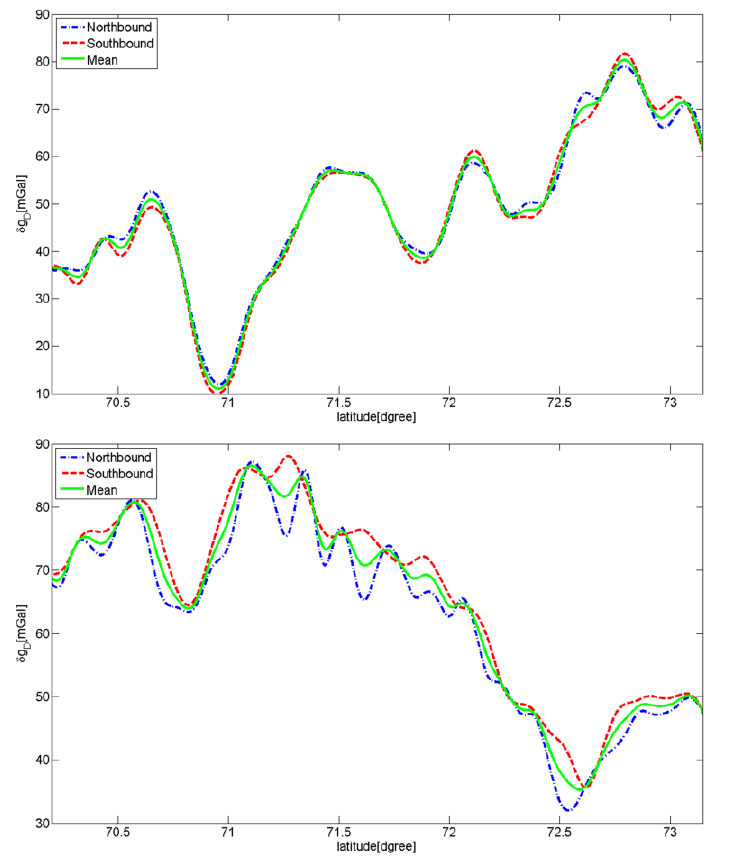
Figure 7. Comparison of airborne gravity disturbance between two passes of the repeated flight A ( top ) and B ( bottom ). The blue lines denote the northbound pass, the red line denote the southbound pass. The dash lines represent EMD and the thin solid lines represent FIR. Larger differences appear around 71.5° and